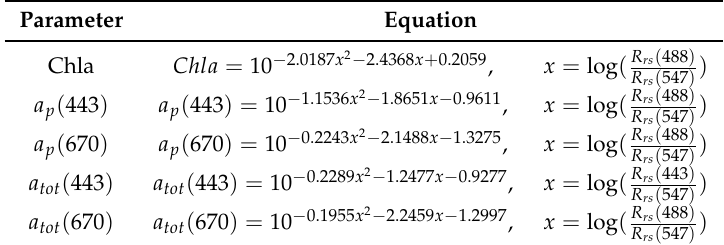
Table 2. Proposed empirical second-order polynomial formulas for retrieving Chla , a p ( 443 ) , a p ( 670 ) , a tot ( 443 ) and a tot ( 670 ) from spectral reflectance ratios adjusted to MODIS AQUA